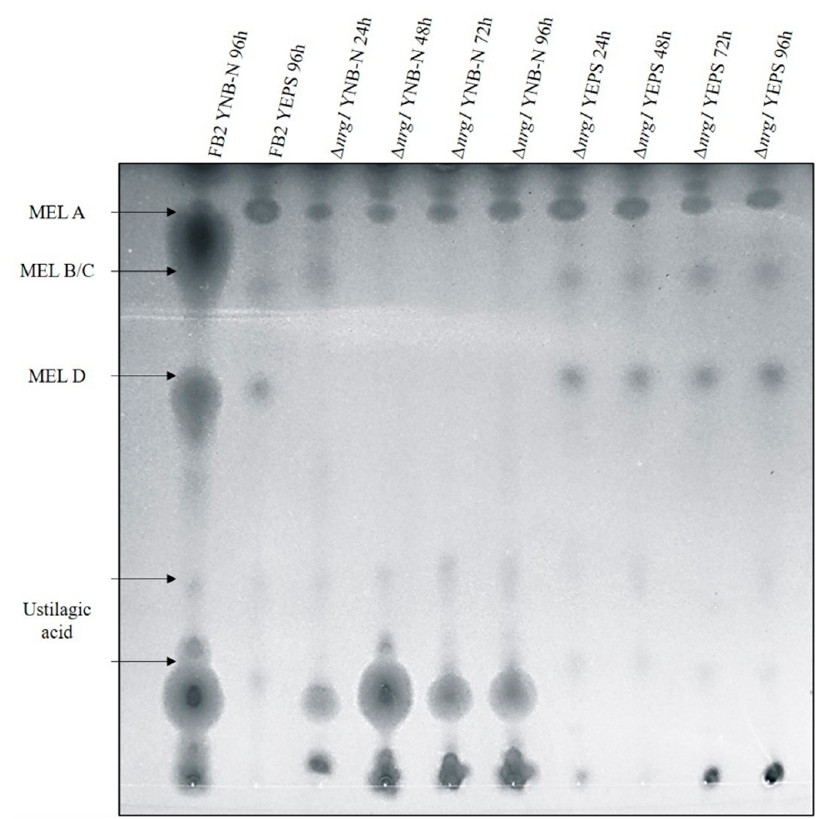
Figure 5. Glycolipids thin-layer chromatography (TLC) production analysis. Wild type and nrg1 mutant strains ethyl acetate extracellular glycolipid extracts were separated by TLC. MELs separate according to their degree of acetylation. Wild type strains had expected MELs charges and ustilagic acid in the specific medium. Δ nrg1 produced slightly higher amounts than wild-type in the preculture medium and barely detectable amounts in the MELs inductive medium; moreover, ustilagic acid production also decreased.